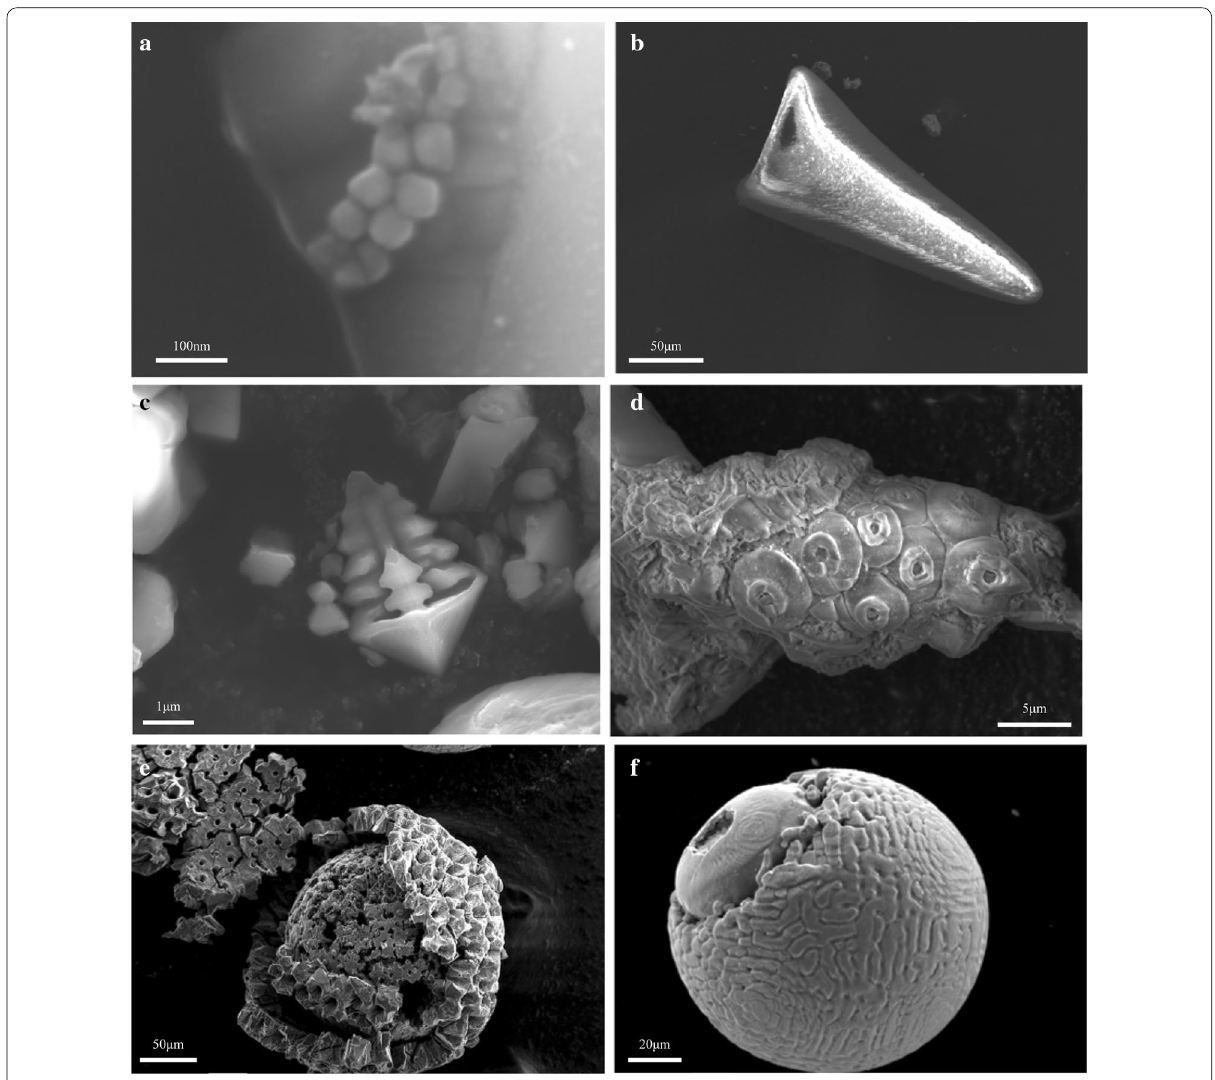
Fig. 3 Secondary electron images of extracted materials observed with FE-SEM; a chain of magnetic particles considered to be fossil biogenic magnetite, b icthyolith, c titanomagnetite with dendritic texture, d coccolith, e foraminifera, and f cosmic spherule. a – c , f are observed with 15 kV, whereas d , e were observed with 5 kV. Particles in a were extracted from Unit 1, and others from Unit 2. The identification of the origin of the grains was primarily based on morphologies with the help of chemical analyses using EDS for grains larger than ~ 10